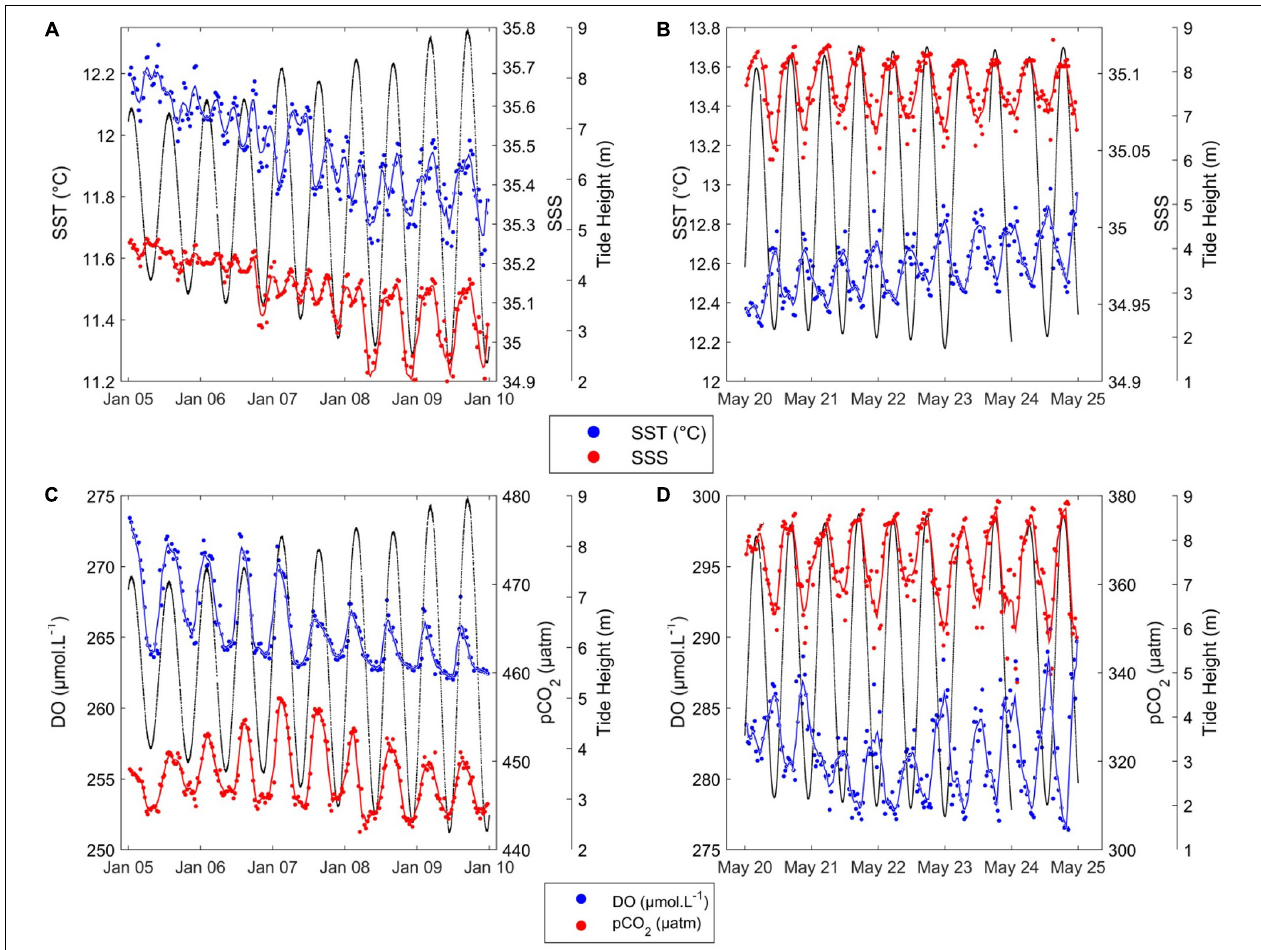
FIGURE 6 | Short-term variability of SST ( ◦ C) (blue) and SSS (red) during (A) winter, from 05/01/2016 to 10/01/2016, and (B) summer, from 20/05/2016 to 25/05/2016; and short-term variability of DO ( µ M) (blue) and pCO 2 ( µ atm) (red) during (C) winter and (D) summer. Black lines represent tidal height (m). Smooth lines in blue and red are obtained using a moving average filter with a 2-h span on the corresponding